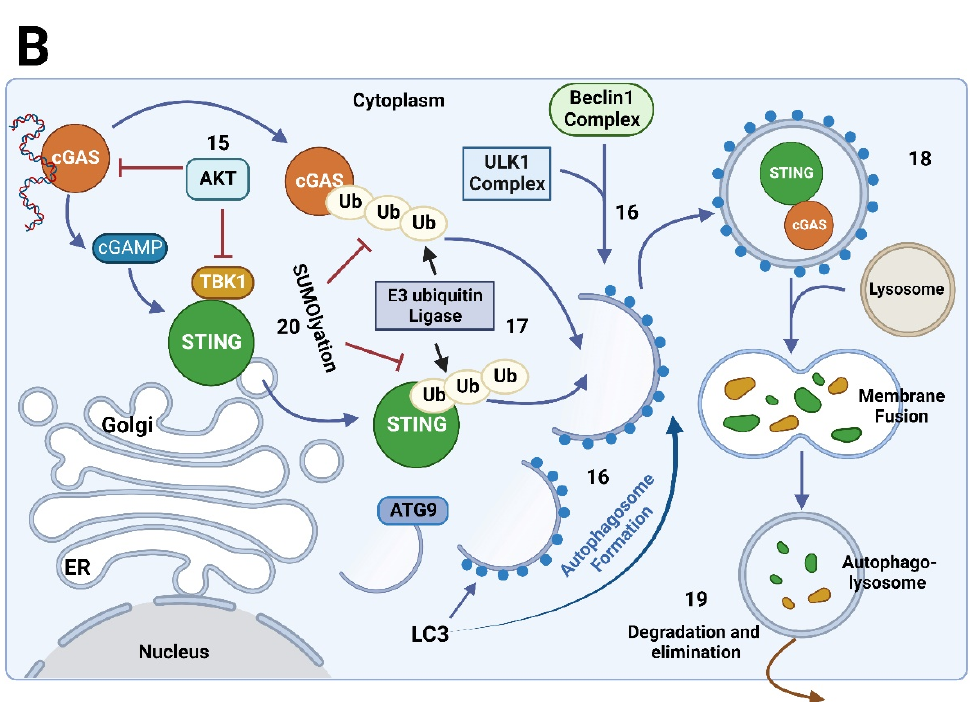
Figure 6. Mechanisms of activation and regulation of the cGAS-cGAMP-STING signaling pathway. ( A ) Source of cytoplasmic DNA: (1) DNA can come from external sources such as pathogenic DNA and virions (and be ingested for digestion in endolysosomes, which can release it into the cytosol) (2) DNA can come from intrinsic sources such as damaged self-DNA, which is released into the cytoplasm after damage to nuclear DNA and/or mitochondrial DNA. The latter moves to the cy- toplasm after permeabilization of the mitochondrial outer membrane during mitochondrial stress, which can release oxidized DNA. (3) DNases such as TREX1, DNase II, and SAMHD1 degrade DNA and limit its recognition by DNA sensors. (4) cGAMP can be transferred between neighboring cells by various mechanisms, including extracellular vesicles and intercellular GAP junctions. (5) Fur- thermore, various CDNs (including cGAMP) can be exported by the reduced folate transporter or SLC19A1. (14) cGAMP can be hydrolyzed by ectonucleotide pyrophosphatase/phosphodiesterase family member 1 (ENPP1). (6) The cGAS/STING signaling pathway is activated with the recognition of cytoplasmic DNA given by cGAS, which produces (7) the second messenger, cGAMP. Subsequently, cGAMP binds to STING (8), which dimerizes and exits the ER towards the Golgi. STING undergoes oligomerization and palmitoylation and then binds to (9) TBK1 to form a complex. (10) TBK1 then phosphorylates IRF3 and I κ B kinase (IKK) in parallel. (11) IKK phosphorylates the inhibitor of NF κ B (I κ B) to generate the release of NF κ B. (12) Subsequently, both transcription factors, IRF3 and NF κ B, translocate to the nucleus and generate the transcription of (13) IFN I and inflammatory cytokines, respectively. ( B ) (15) The inactivation of cGAS and TBK1 is mediated by AKT phosphorylation and the degradation of the action of several types of caspases. (16) The degradation of cGAS and STING is generated after the formation of (16) Beclin and ULK1 complex to activate the (16) autophago- some formation (17) previous ubiquitination of cGAS and STING mediated by E3-ubiquitin Ligase. (18) STING, after being activated, induces ER stress and ULK1, together with Beclin-1, initiates the formation (18) of the autophagosome with the participation of ATG9 and LC3 proteins, where cGAS and STING will be (19) degraded. (20) One of the mechanisms that inhibit the degradation of cGAS and STING proteins by autophagy is the SUMOlyation of both